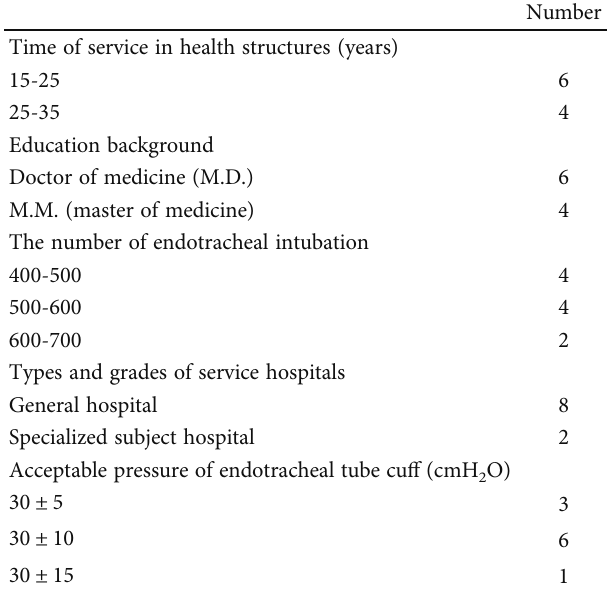
Table 3: Characteristics and situation of form responding